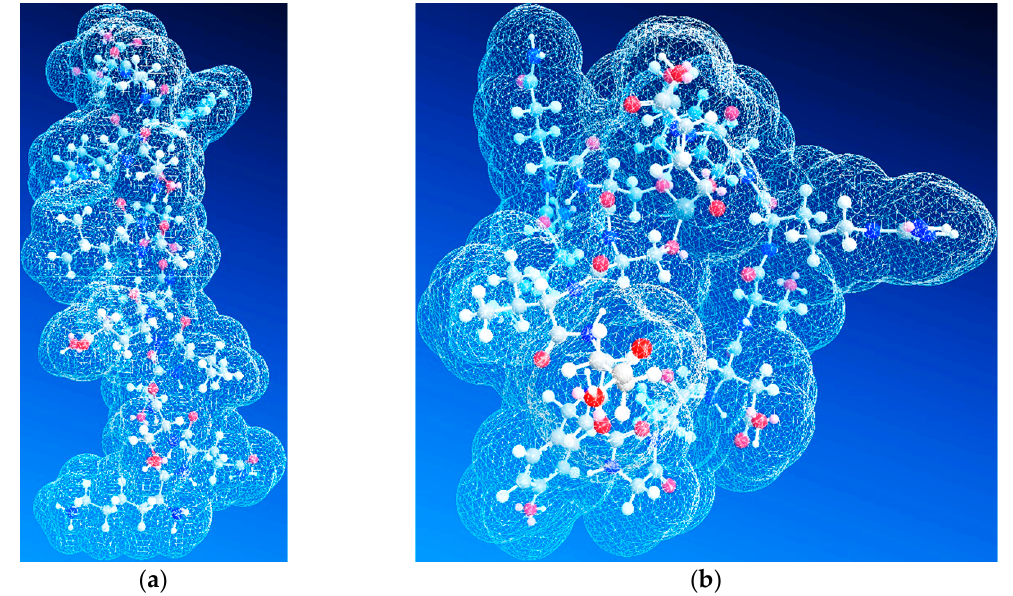
Figure 16. Accessibility of solvents to: ( a ) A β (1–16) S 36,13,14 ; ( b ) A β (1–16) S 36,13,14 (24.30)94 + Al 3+ .